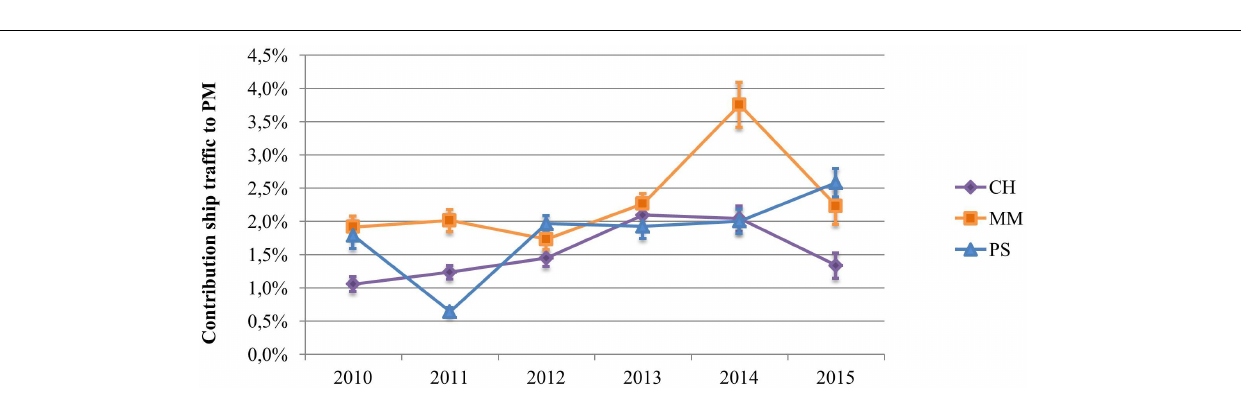
FIGURE 8 | Annual average of the primary contribution of ship traffic to PM 10 , calculated using the Agrawal equation, in the three monitoring sites of Chioggia (CH), Malamocco (MM), and Punta Sabbioni (PS). The associated error is shown.